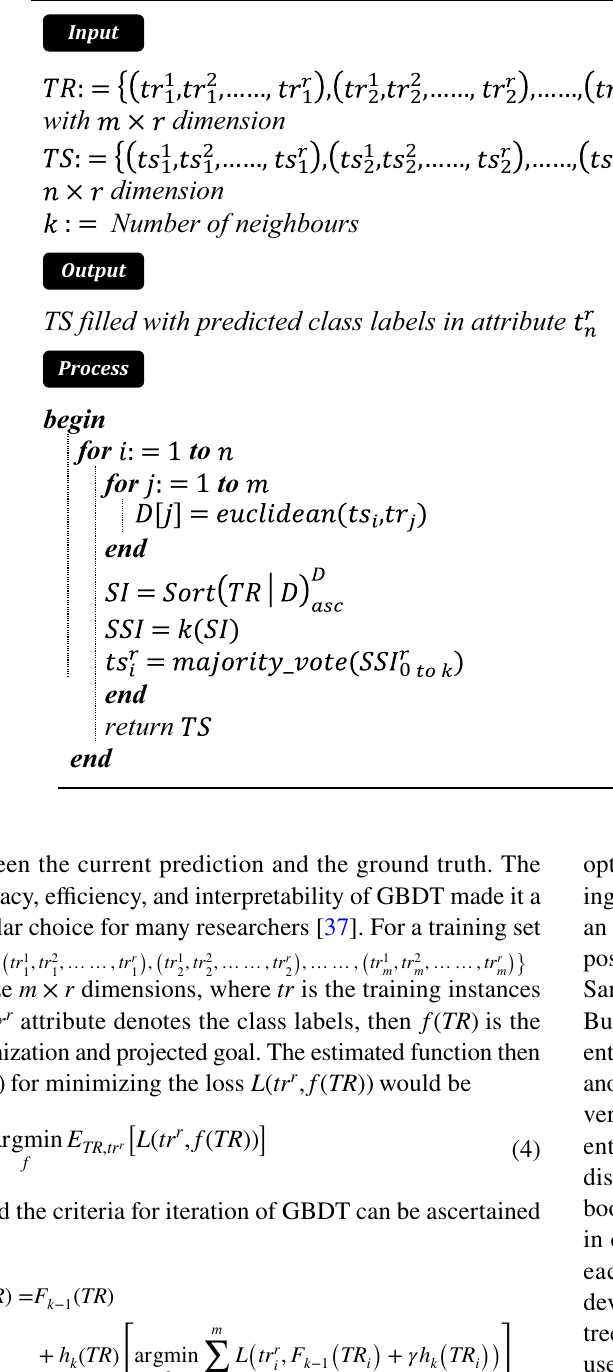
Table 2 Pseudocode of k -NN